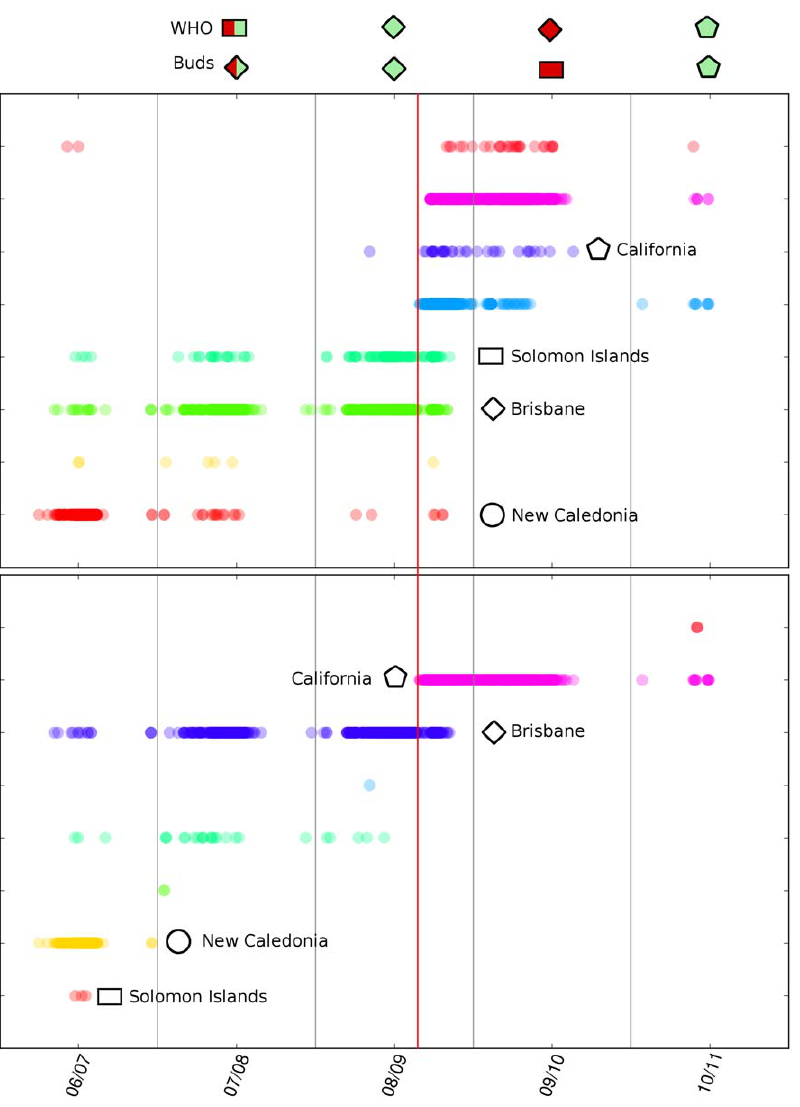
Figure 3. Clusters and time evolution for H1N1. (upper part) Rohlin clusters time evolution for H1N1. (lower part) Hamming clusters time evolution for H1N1. The reference WHO sequences are shown by the corresponding symbols, as indicated in Table 2. In the upper part, we indicate the vaccine choice according to the WHO indication (up) and to buds criterion (lower). Green and red colors indicate right and wrong choice. In this case, some of the symbols does not correspond to a specific HI test, so they are indicated by a star and a pentagon. Notice the onset of the pandemic virus and the failure of the bud criterion after that line.